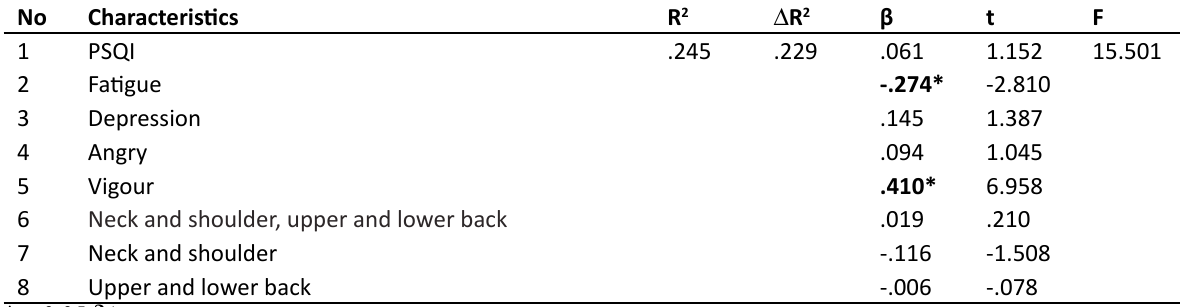
Table 3. Multiple Regression Analysis on the Predictor of Physical Activity No